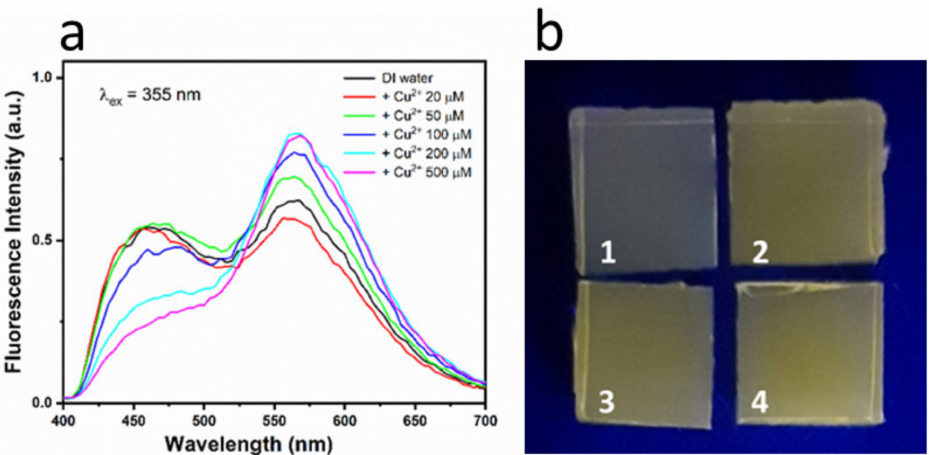
Figure 9. ( a ) Fluorescence emission spectra of hydrogel Aga-NSCD films after immersion in DI water with different Cu(II) concentration; ( b ) photographs of colorimetric sensing with hydrogel Aga-NSCD films (1) in pure DI water, 100 µ M Cu(II) in (2) DI water, (3) tap water and (4) lake